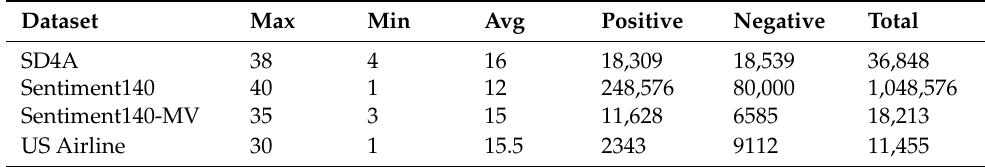
Table 1. Detailed statistics of the dataset: We used four different datasets to verify our model’s